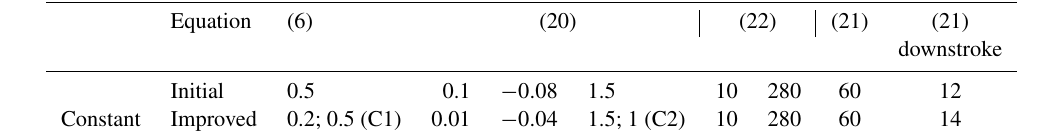
Table 2. Constants used for optimization.